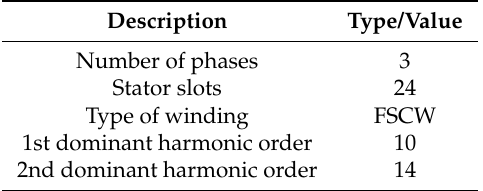
Table 1. Main characteristics of the stator